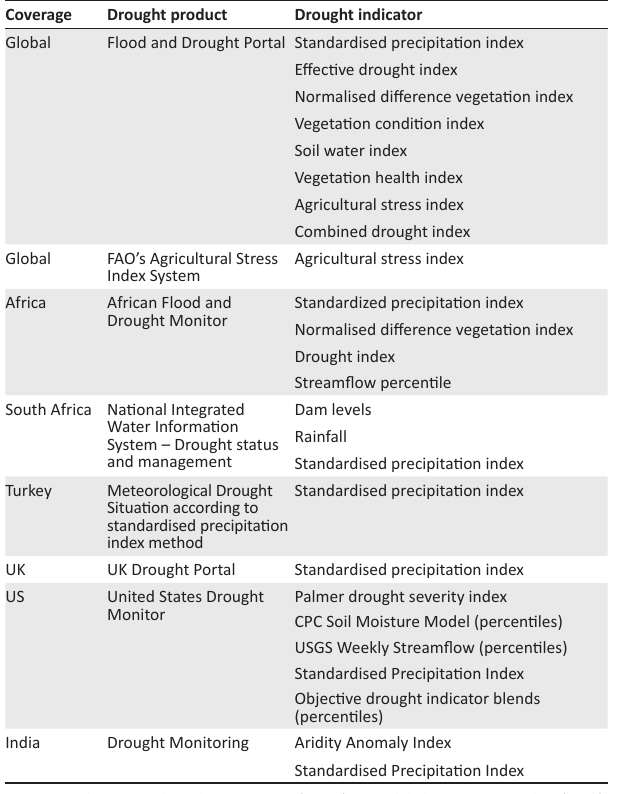
TABLE 2: Global and national drought monitoring products.